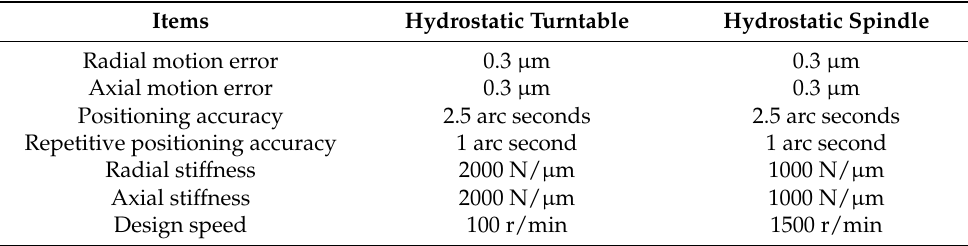
Table 6. Design indices of hydrostatic bearing.